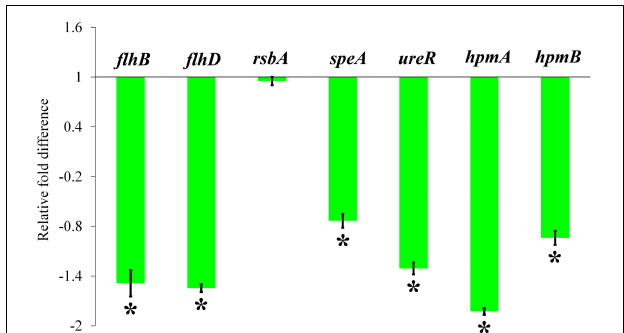
FIGURE 8 | Effect of HMB on virulence genes expression in Proteus mirabilis . Bar chart depicting the relative fold difference in the expression level of virulence genes of P. mirabilis in the presence of HMB at MBIC. Data represent mean values ( n = 3) ± standard deviation. ∗ indicates significance at P < 0.005. HMB, 2-hydroxy-4-methoxybenzaldehyde; MBIC, minimum biofilm inhibitory